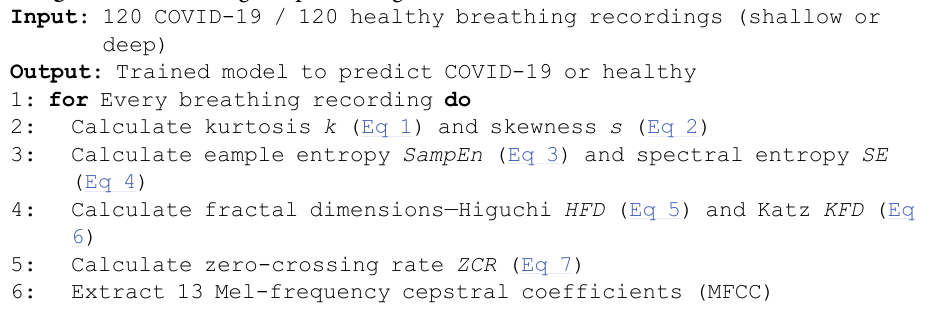
Algorithm 1 Training Deep Learning Model for COVID-19 Prediction